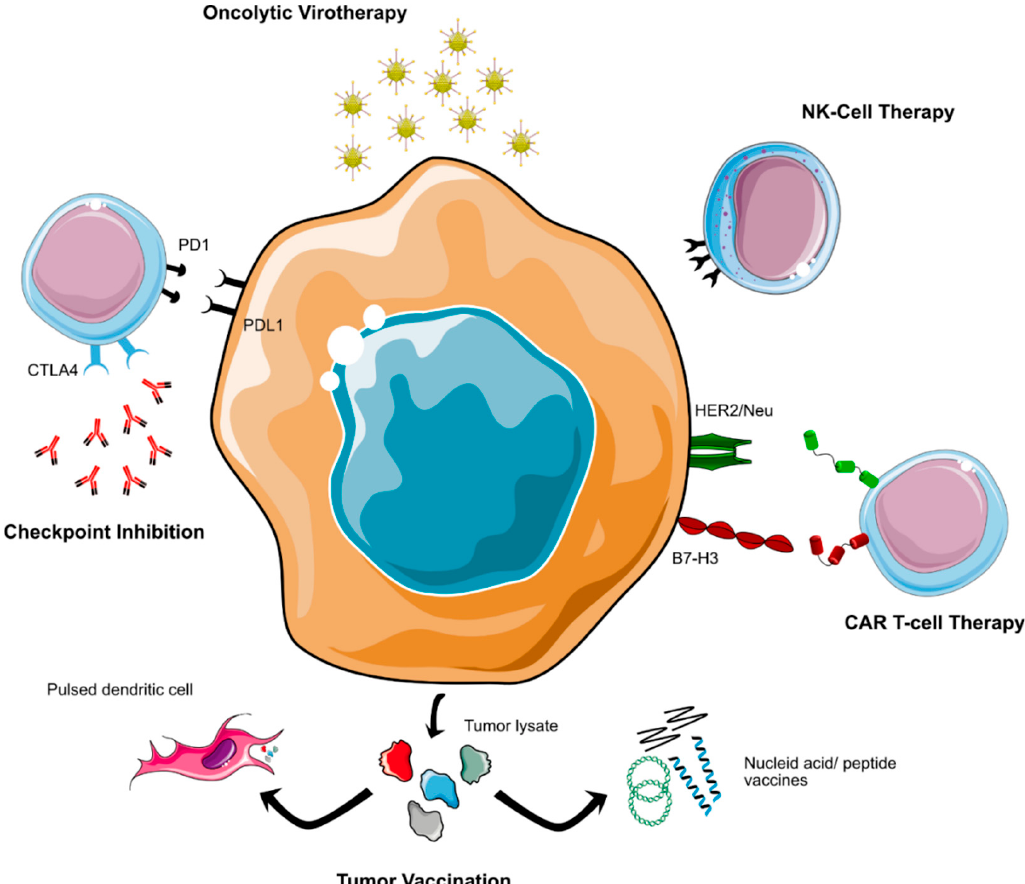
Figure 2. Immunotherapeutic approaches currently tested for non-WNT/non-SHH MB.